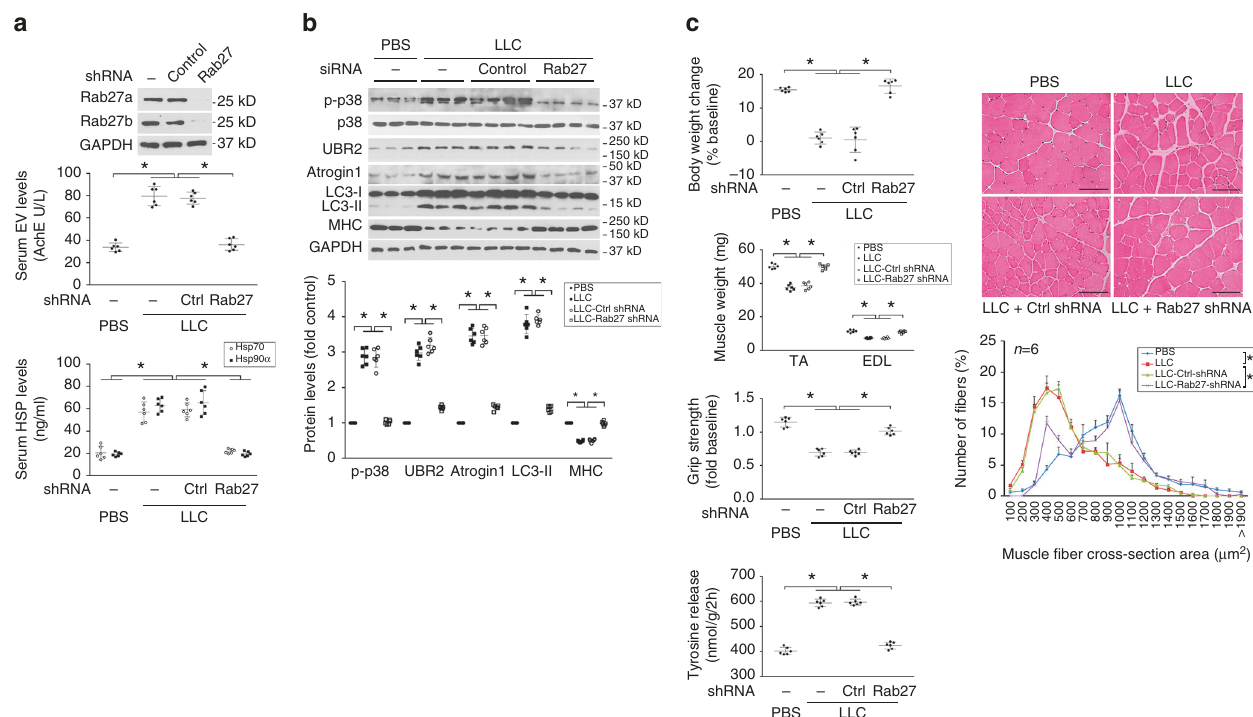
Fig. 7 Tumor cell-released Hsp70/90-expressing EVs are critical to the development of muscle wasting in mice. a Elevation of serum Hsp70/90 in LLC tumor-bearing mice is dependent on EV release. LLC cells transduced with lentivirus encoding Rab27a- and Rab27b-speci fi c shRNA or empty vector were analyzed for knockdown effect by western blotting ( top ). Mice were then implanted with Rab27-de fi cient or control LLC cells. In 21 days serum levels of EVs, Hsp70/90 were analyzed. b Rab27-de fi cient LLC tumor does not induce muscle catabolism in mice. Mice derived from a were analyzed for activity of the catabolic markers in TA. c Rab27-de fi cient LLC tumor does not induce muscle wasting in mice. Mice derived from a were analyzed for muscle